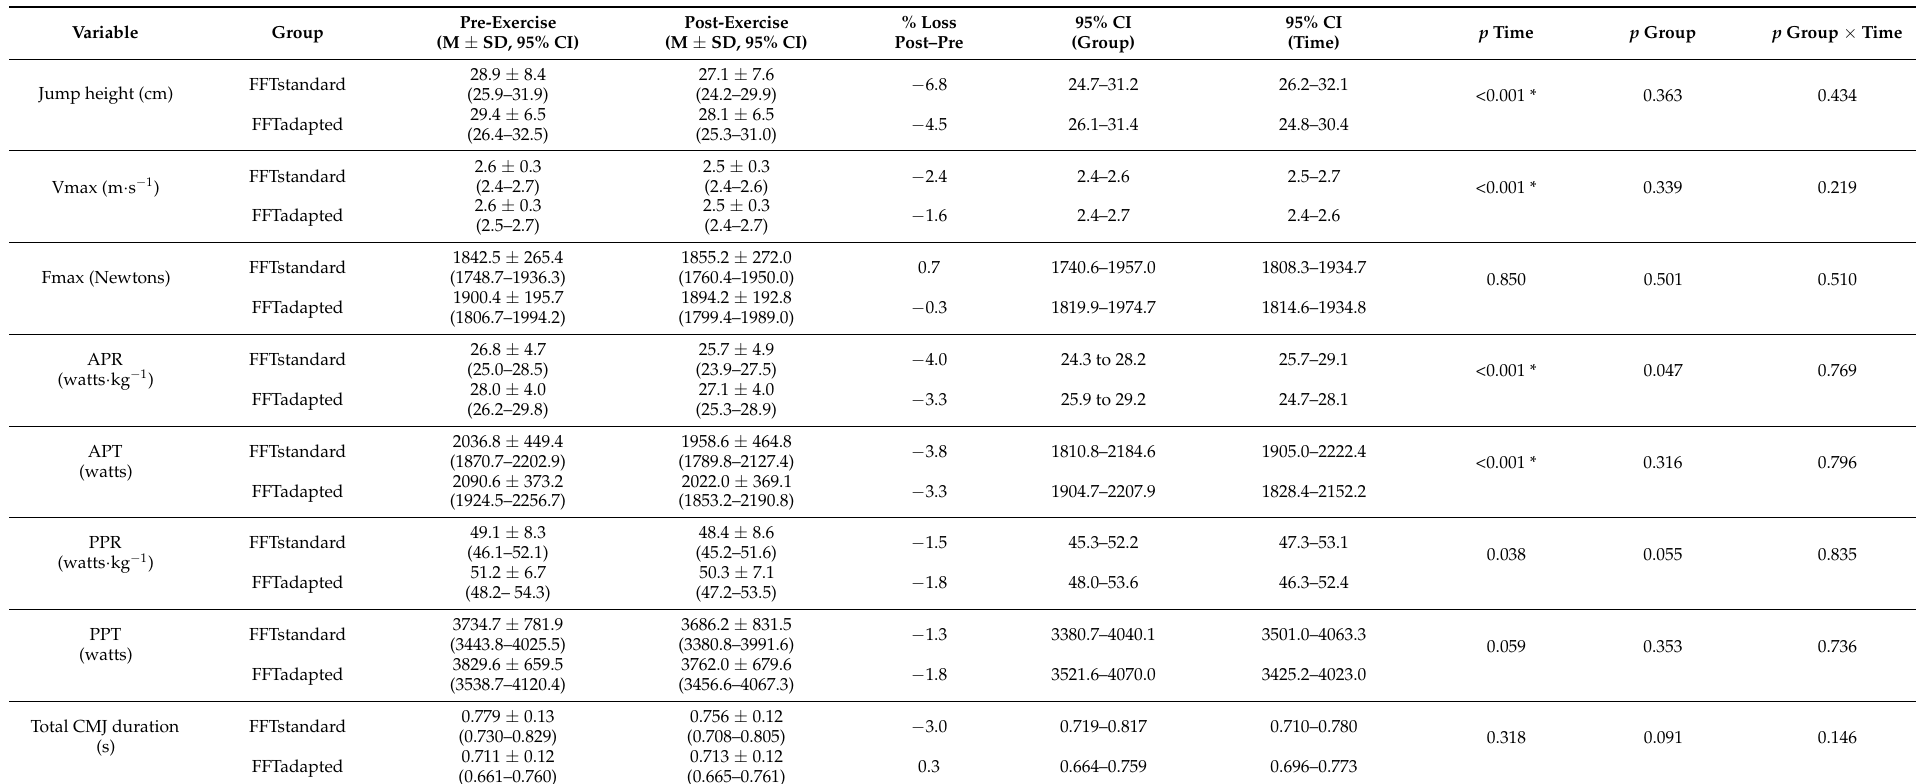
Table 2. Jump ability-related variables recorded pre- and post-exercise in the standard and adapted FFT